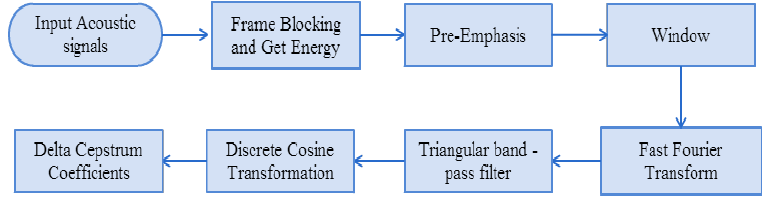
Figure 13. Process of MFCC characteristic parameter